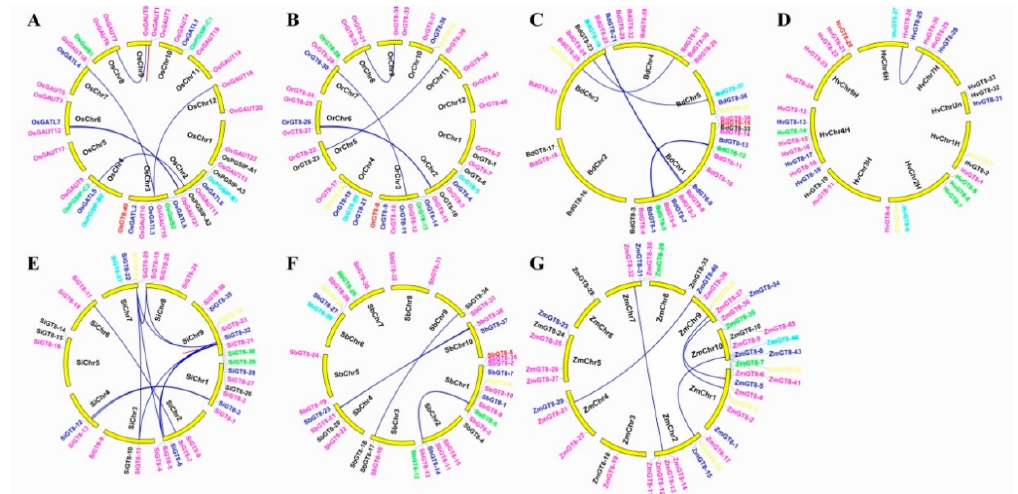
Figure 3. The chromosome location and duplication events of GT8 genes in seven species, namely, O . sativa ssp. japonica ( A ), O . rufipogon ( B ), B . distachyon ( C ), H . vulgare ( D ), S . italica ( E ), S . bicolor ( F ), and Z . mays ( G ). The blue lines represent whole genome duplication (WGD)/segmental duplication and red lines mean tandem duplication events. The different color genes belong to different subfamilies.